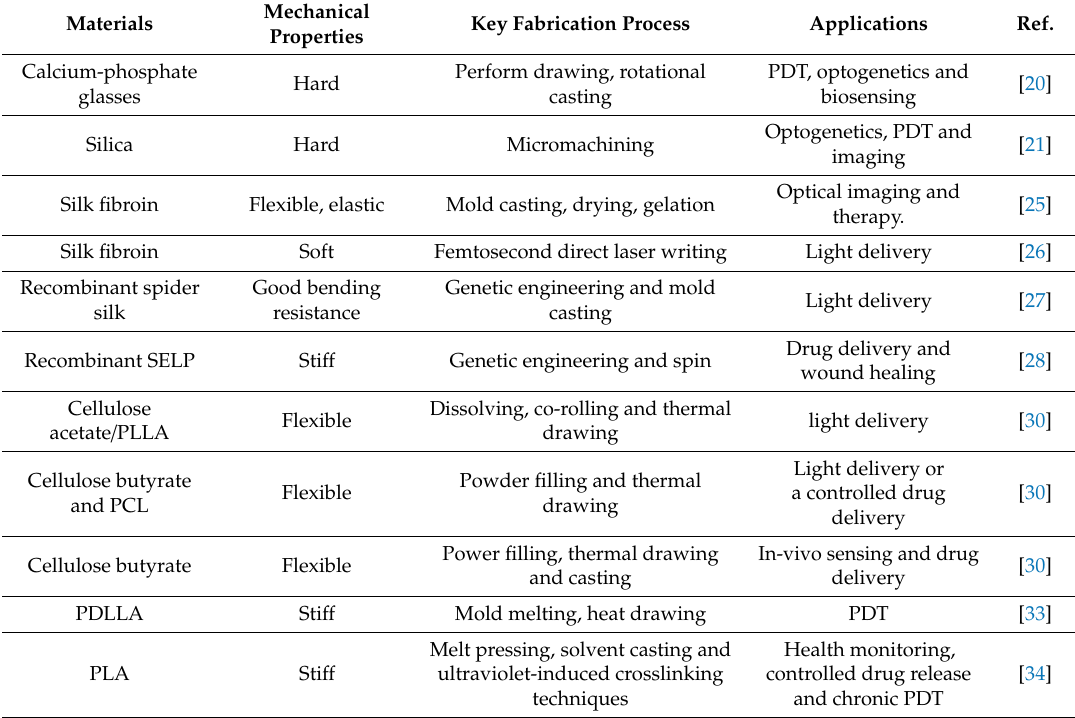
Table 2. Mechanical properties, fabrication process and applications of optical